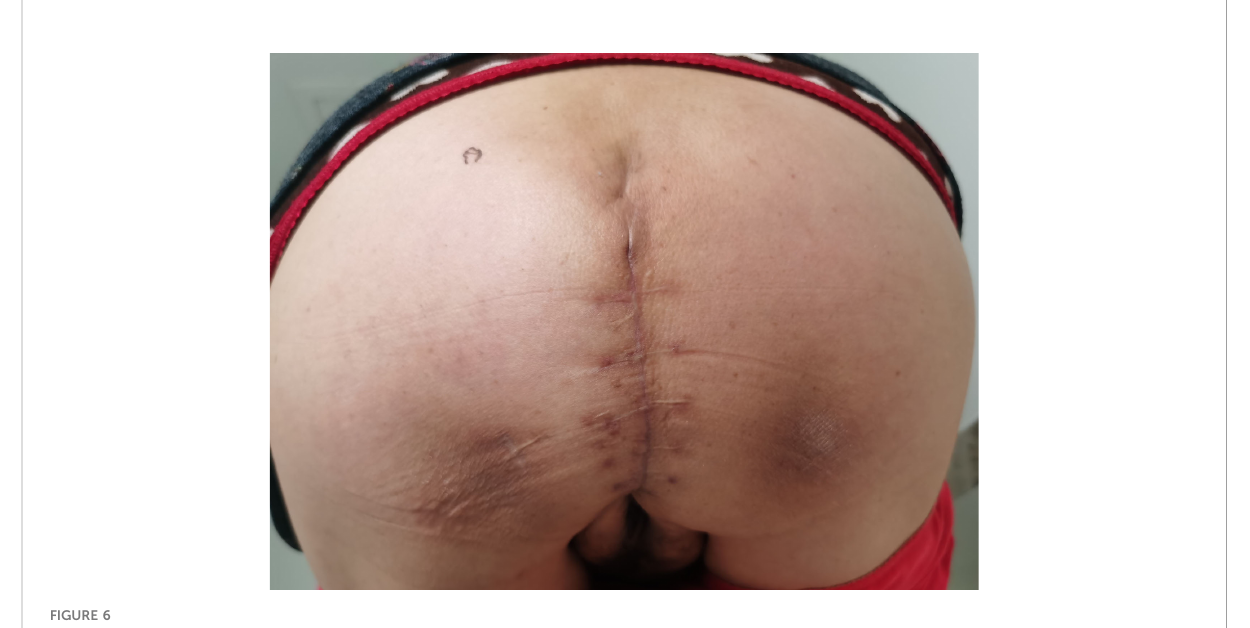
FIGURE 6 Image of the hernia postoperatively.